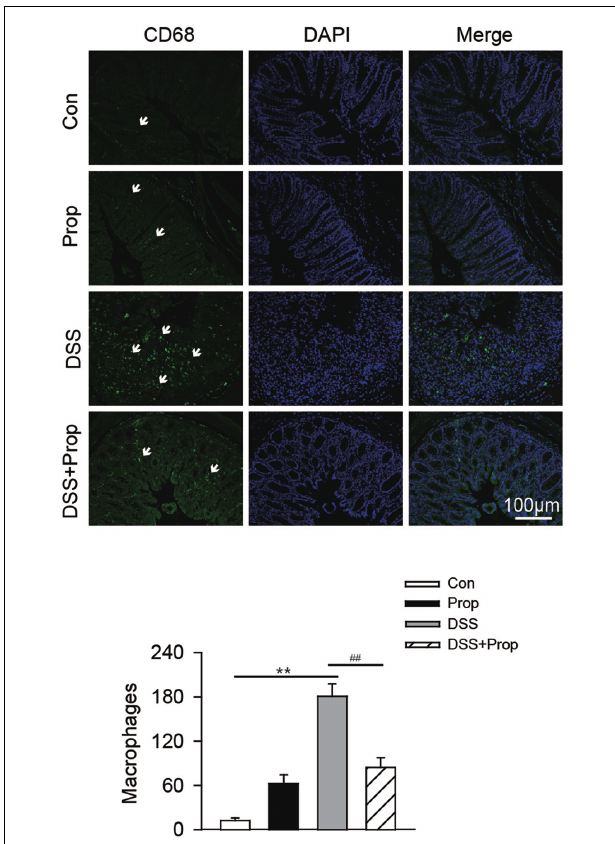
FIGURE 5 | The effects of sodium propionate on macrophages with CD68 marker in the colonic tissue. Macrophages were determined by immunofluorescence in colonic tissues. CD68 was used as the marker of macrophage/monocyte infiltration in the colon of mice and visualized by fluorescence microcopy (green staining). Nuclei were stained with DAPI (blue staining). Arrows indicate CD68-labeled macrophages in the colon. Images were representative of 6–8 mice in each group. Scar bars were 100 µ m. Morphometric analysis of macrophages in the colon was also performed. Data are presented as mean ± SD. n = 6–8 per group, ∗ P < 0.05, ∗∗ P < 0.01 vs. control group; # P < 0.05, ## P < 0.01 vs. DSS